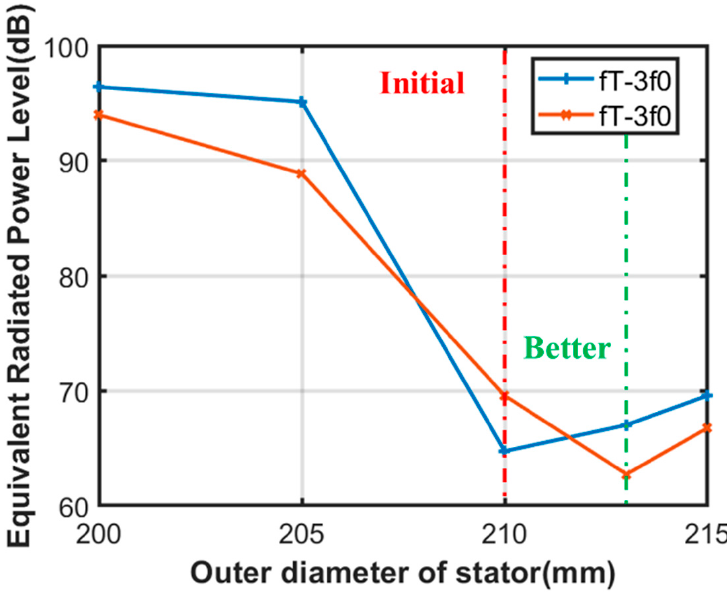
Figure 15. Stator outer diameter optimization.